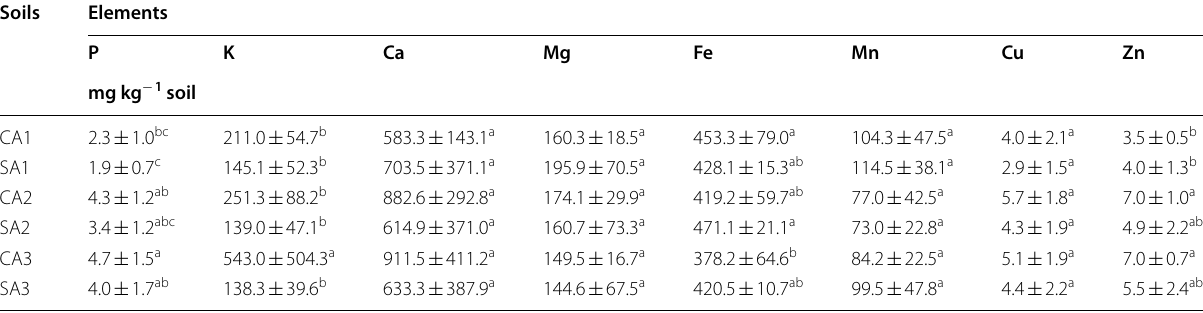
1, 2 and 3 indicate successive trimester samplings carried out on October 2016, January 2017 and April 2017, respectively. The extractable elements including P, K, Ca, Mg, Fe, Mn, Cu, and Zn were determined by inductively coupled plasma emission spectroscopy. Results are shown as mean